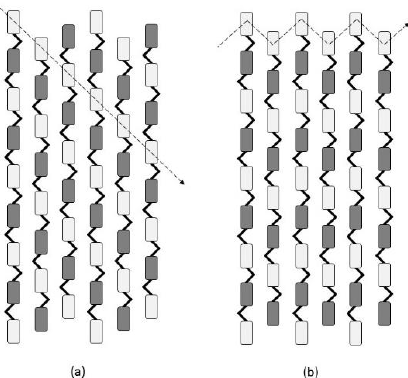
Figure 6. Cellulose conformation. Conformation of: ( a ) cellulose Iα; ( b ) cellulose Iβ. The grey and white rectangles represent glucose molecules linked together by β-(1-4) linkages ( < and > ). Two glucose molecules are linked such that each glucose molecule is rotated 180° in relation to each other, represented by grey and white rectangles. These two 180° linked glucose molecules form a cellobiose unit, the repeat unit of cellulose.